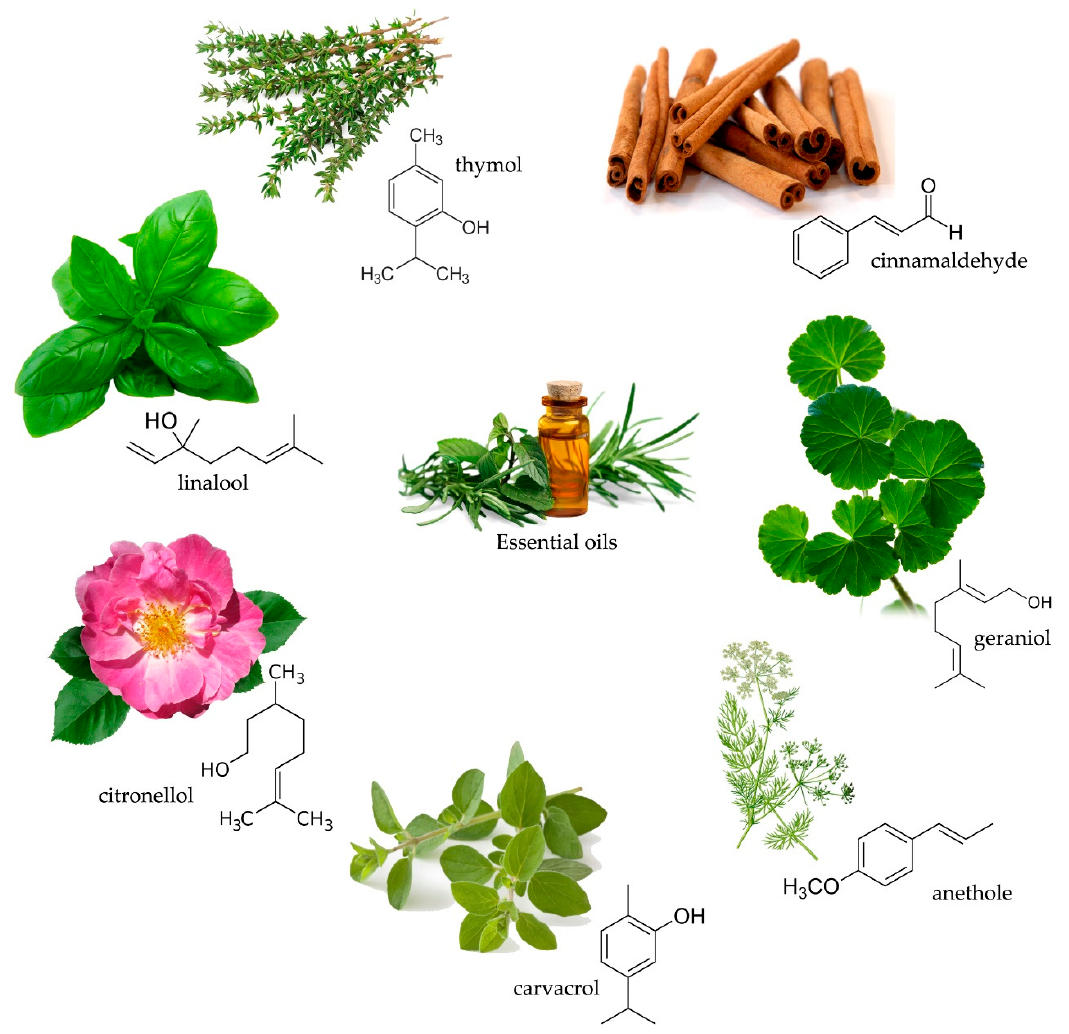
Figure 1. Chemical structure and exemplary plant sources of the selected antifungal compounds of essential oils.